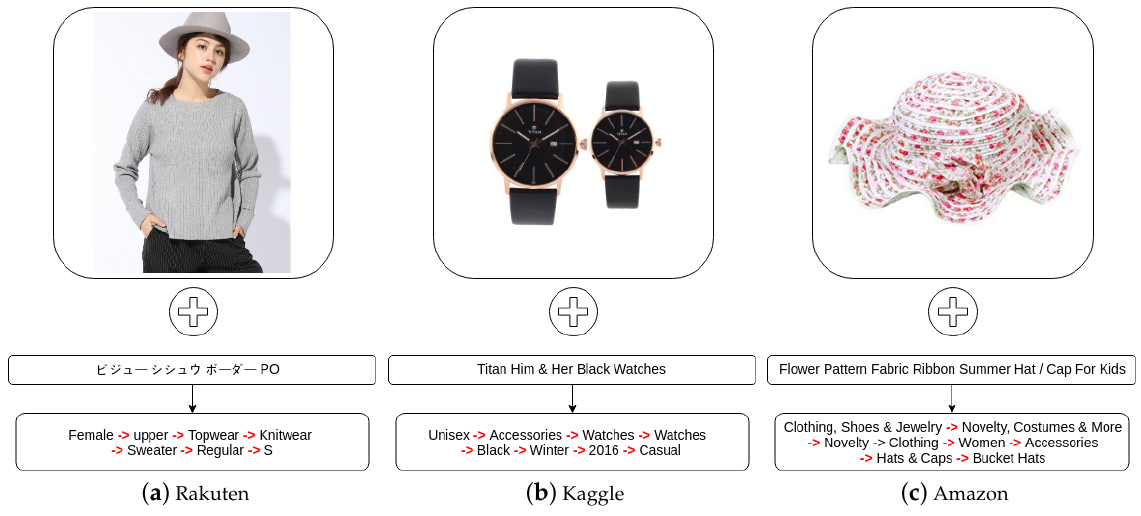
Figure 4. The examples of fashion product items for each of the three